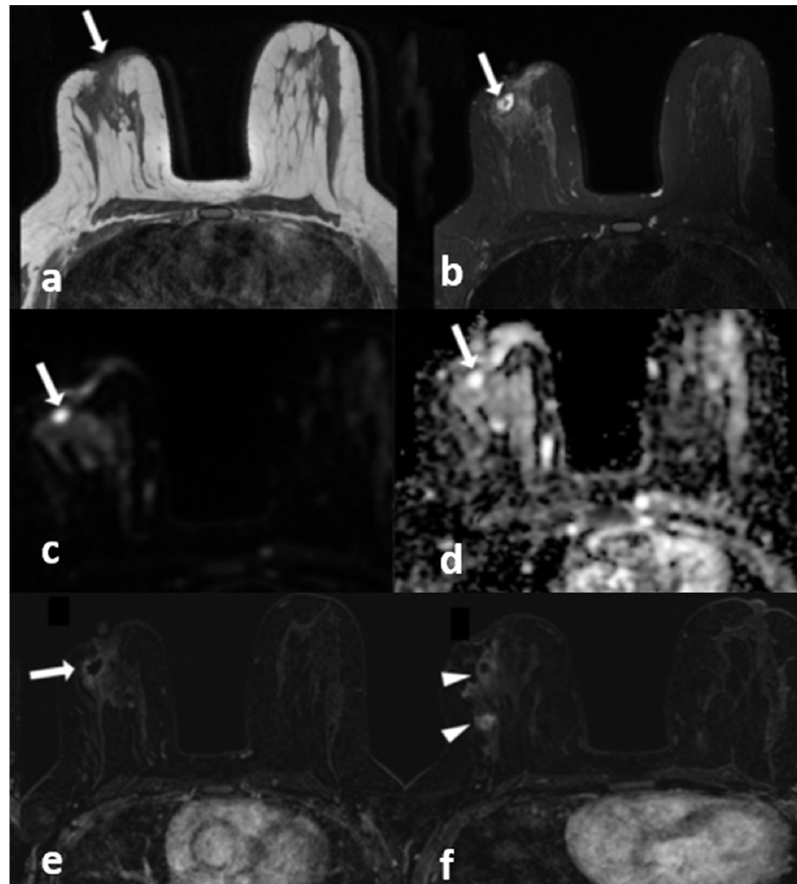
Figure 6. A 42-year-old woman with histopathologically proven invasive ductal carcinoma involving the right breast. ( a ) T1-weighted fast spin echo axial MR image of the patient shows parenchymal asymmetry in the retroareolar region along with nipple retraction (arrow). ( b ) Axial fat-saturated T2-weighted fast spin echo MR image, corresponding to ( a ), which reveals a cystic lesion (arrow) with a moderate signal increase in the parenchyma. ( c ) Diffusion-weighted and ( d ) ADC map show that the cystic lesion had no restriction of diffusion (arrows). ( e ) Contrast-enhanced subtracted image demonstrates a slight thin wall enhancement around the cystic lesion (arrow); ( f ) following the inferior image to ( e ) shows similar contiguous lesions demonstrating peripheral slight enhancement in the adjacent parenchyma (arrowheads).